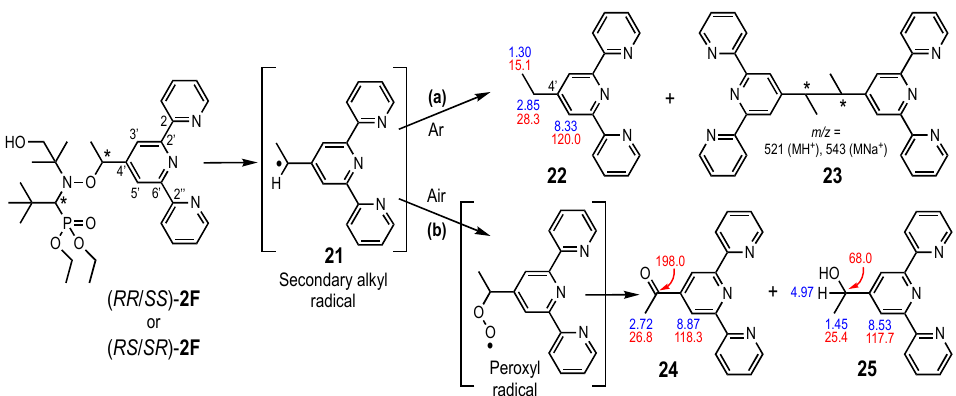
Scheme 5. Reaction of ( RR / SS )-2F or ( RS / SR )-2F with heme under inert atmosphere (route a) or in the presence of air (route b). The blue and red labels stand for the 1 H and 13 C-NMR